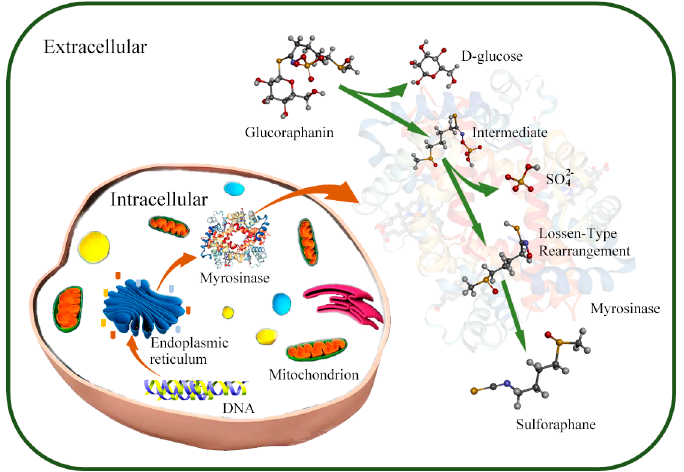
Figure 1. Mechanism of SFN production by microorganisms. In microorganisms, myrosinase is synthesized and secreted to environment through ribosome and endoplasmic reticulum under the myrosinase gene regulation; the glucoraphanin is converted into sulforaphane under the action of myrosinase in extracellular environment.